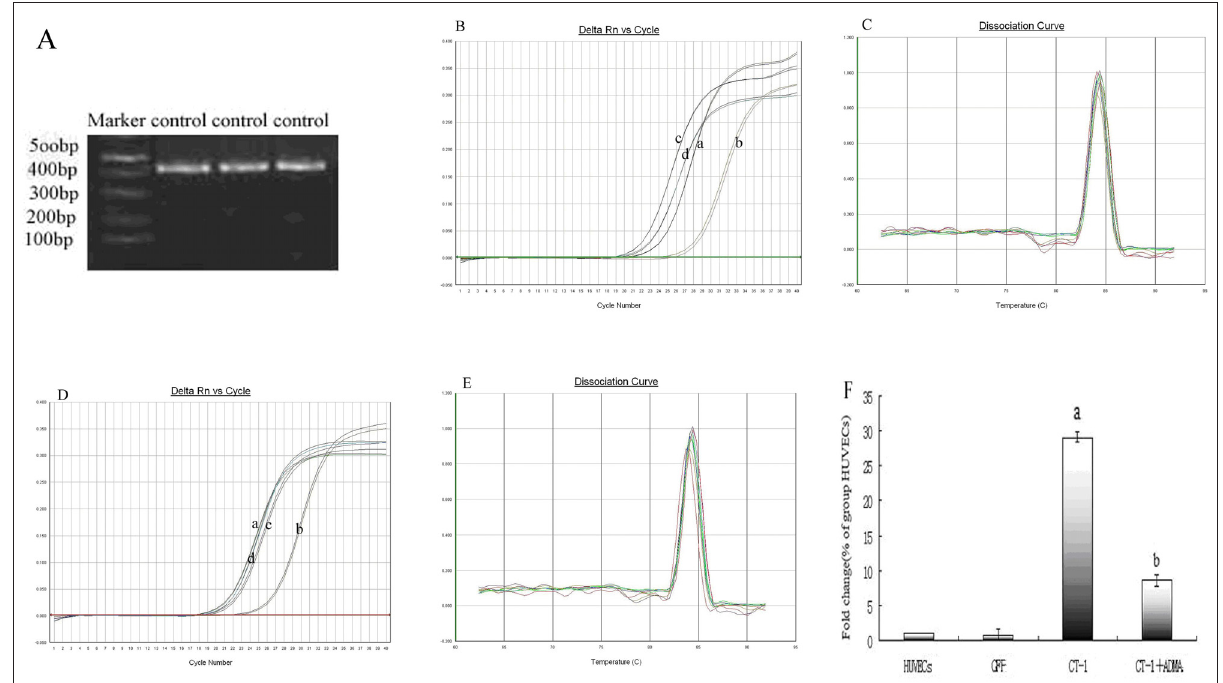
Fig. 6. The expression of eNOS mRNA after pEGFP-N1-CTF1-GFP transfection. (A) eNOS mRNA PCR product by agarose gel electrophoresis. (B) eNOS mRNA Gene amplification curve. (C) eNOS mRNA gene dissolution curve. (D) β-actin Gene amplification curve. (E) β-actin gene dissolution curve. (F) The results of 2 -△△Ct ·a-HUVEC group. b-GFP group. c-CT-1 group. a P <0.05 vs HUVECs